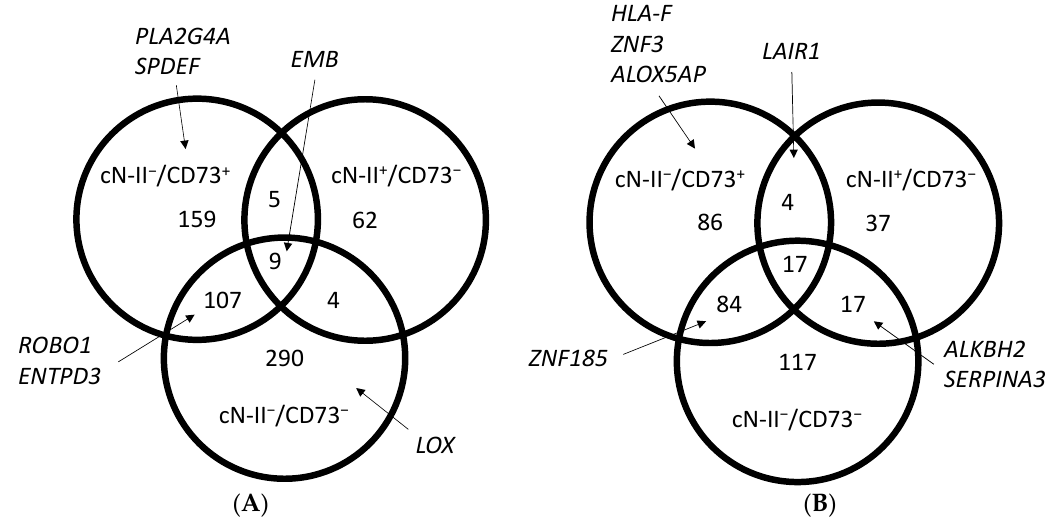
Figure 2. Venn diagrams showing the number of transcripts with at least a 2-fold higher ( A ) or lower ( B ) expression than in cN-II + /CD73 + cells, and with a p -value lower than 0.05. Only transcripts that were positive (FPKm > 1) in at least one model were included in the analysis. Complete list of transcripts is available in Supplementary Table S2.